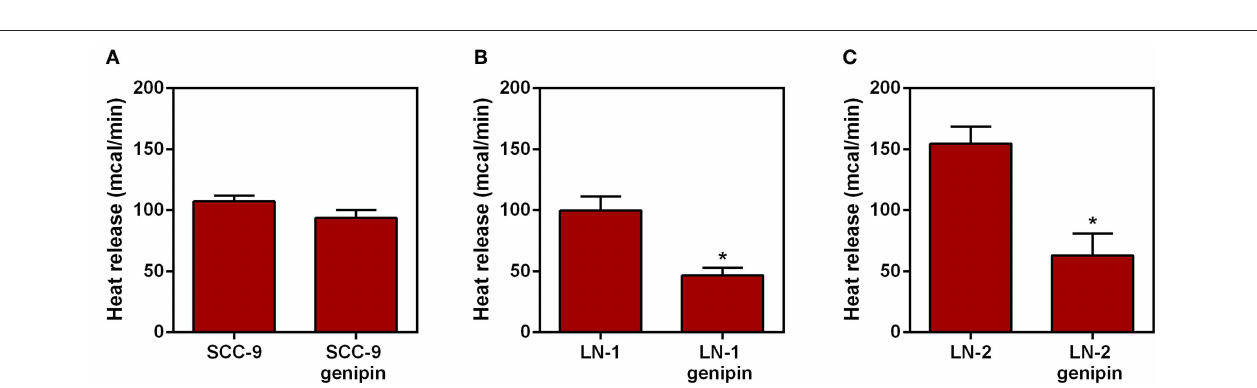
FIGURE 5 | Effect of genipin on the heat release by human oral squamous carcinoma cells SCC-9, LN-1 and LN-2 cells.The bars represent the release of total heat of living cells in 35min of experiment. (A) Heat release by SCC-9 cells untreated and treated with 50 µ M of genipin; (B) heat release by LN-1 cells untreated and treated with 50 µ M of genipin; (C) heat release by LN-2 cells untreated and treated with 50 µ M of genipin. Values were expressed as mean ± SEM. * p <